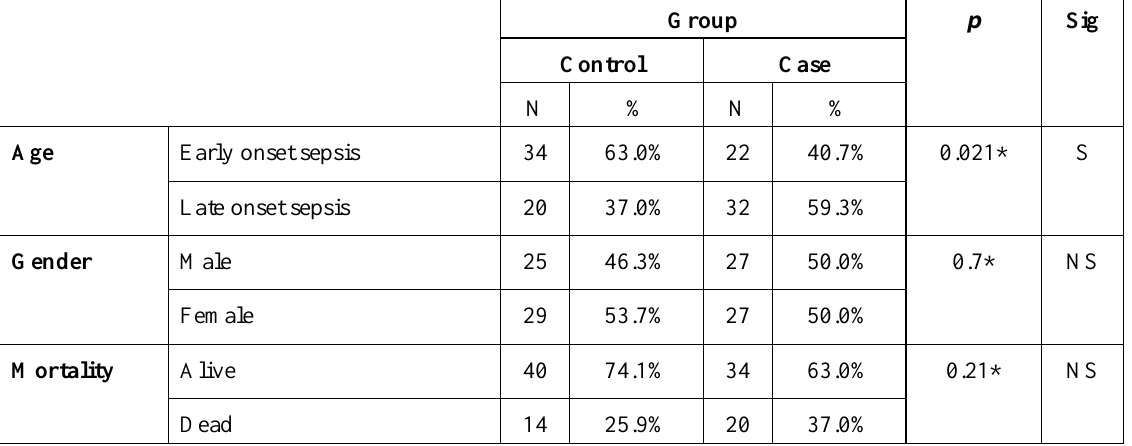
Table 1. Comparison between cases and controls as regard age, gender and mortality.